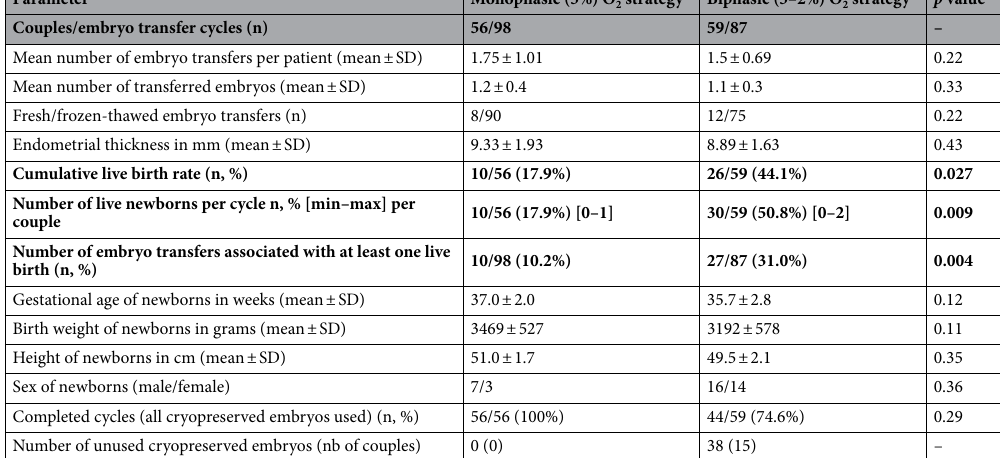
Table 2. Clinical and biological parameters of IVF cycles used for the secondary objective (i.e. cycles associated with morula or blastocyst transfers). BMI body mass index, IVF in vitro fertilization, IU International Unit, PN pronuclei. Data in bold indicate statistically significant